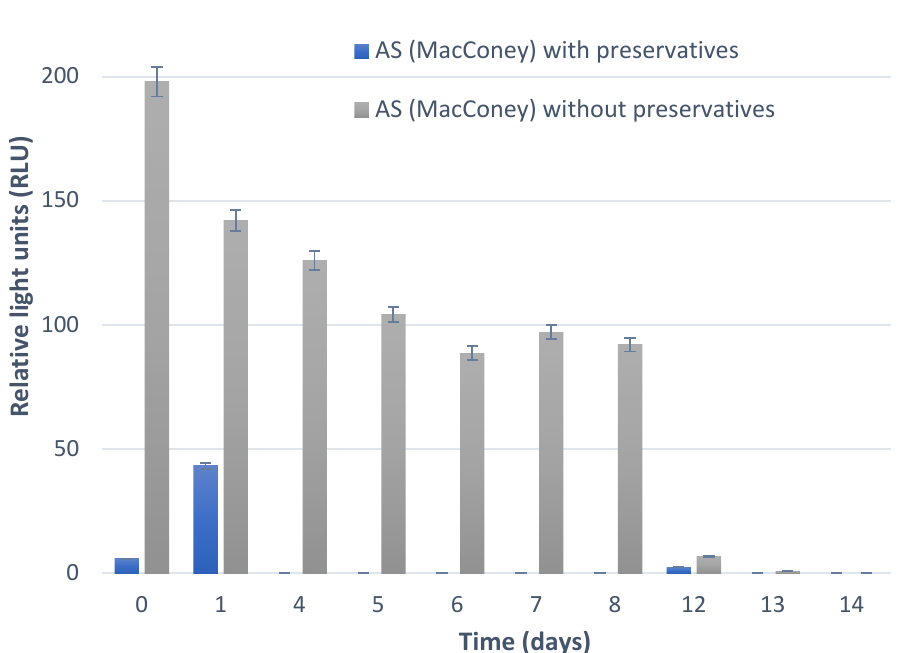
Figure 3. RLU mean values of aubergine salad (AS) with and without preservatives in relation to storage time, after incubation in Sabouraud liquid medium for 24 h at 35 °C. AS showed its self-stabilization ability after 13 days, even without the use of preserv- atives. This phenomenon was also observed in our previous work [7] during the study of the self-stabilization ability of another traditional Greek ready-to-eat deli salad, the tzat- ziki salad. Therefore, it can be concluded that the use of preservatives is not obligatory in order to stabilize AS.